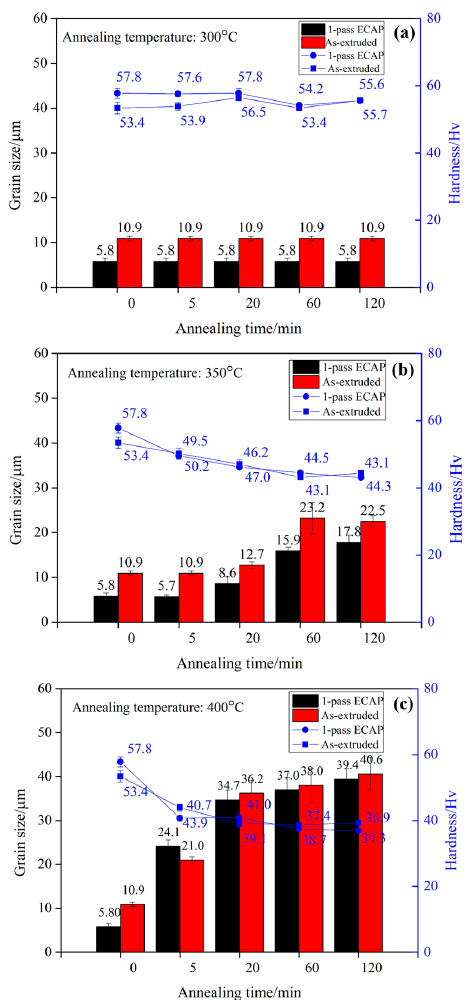
Figure 9. The grain size and hardness versus annealing time at ( a ) 300 °C; ( b ) 350 °C; ( c ) 400 °C of as-extruded, ECAPed (1-pass) materials. as-extruded, ECAPed (1-pass)